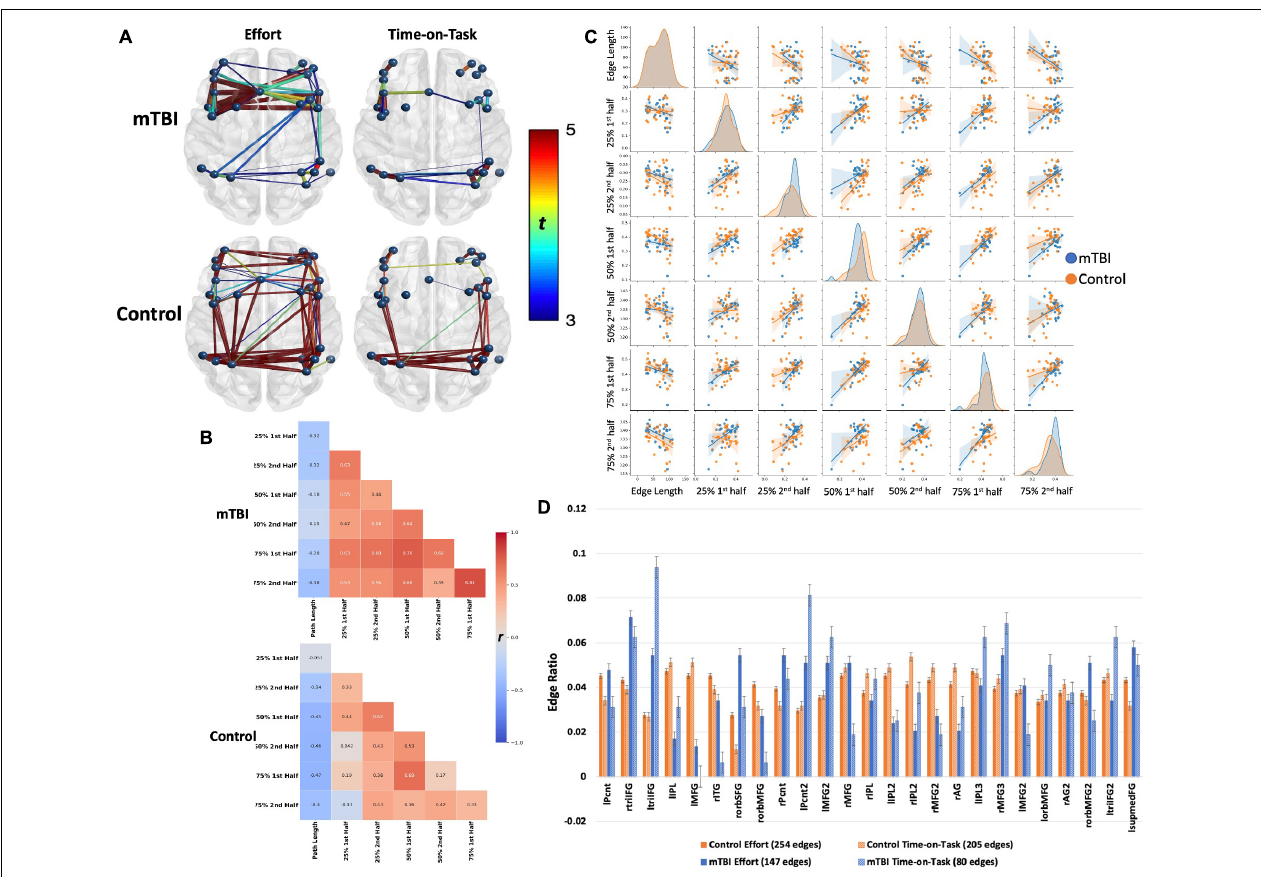
FIGURE 5 | Frontoparietal network connectivity by group. Both groups demonstrated robust main effects for effort level and TOT with similar spatial distributions across effects (effort or TOT) and across groups. The effects were stronger in the control group ( t -values presented by the color spectrum) than in the mTBI group but with small effect size ( d = 0.25). Spatial distribution was larger for the effort level than for TOT in both groups, but effect sizes did not differ (mTBI d = 0.31 for both, control d = 0.41 for effort, d = 0.4 for TOT). However, on visual inspection of the network, the distribution of significant edges and stronger edges ( t -values presented by color spectrum and edge thickness), was greater among the frontal nodes than the parietal nodes in the mTBI group. In contrast, connectivity was well distributed across nodes in the control group. This pattern, i.e., more and stronger connections in frontal than parietal nodes, is also evident in the TOT effect. The (B) heatmaps and (C) pairplot present the correlation strengths and distributions ( C , center diagonal) for edges that were significant at the effort level and TOT effects by group, and the scatter plots present the relationships between each of the effort levels by TOT. The heatmaps demonstrate that the mTBI group ( B , top) had stronger FC throughout the task with only slight increases in FC for the first half of each trial. In contrast, the connectivity of the controls varied consistently for the first half of the 50 and 75% effort levels. The pairplot presents the distributions of FP connectivity strength for the significant edges by group, and while the NBS results did not indicate strong group differences in the FP (evident in A ), these plots make evident the differing patterns of FC relationships by group. First, the distributions differ in the OC by TOT, with a more kurtotic peak for the first trial at 25% that flattens in the second half at 25%, and then remain near the same for the other effort levels with slight skew to the right (stronger connectivity). This was not the case in the mTBI group where the distribution was kurtotic for all effort levels. In both groups, there were bimodal distributions, with smaller numbers of participant data skewed to the left (weaker connectivity). Also evident in the (B) heatmaps is the negative correlation of edge length with FC. This negative correlation was slightly weaker in the mTBI group, and there was a trend toward more negative FC path length correlations with increasing effort level in the OC group. (D) Node degree, presented as the number of nodes by the total number of edges for each effect and group, demonstrated group differences in the numbers of connections each node was engaged in, with higher degree in frontal nodes for the mTBI group relative to the control group. The involvement of frontal nodes was particularly higher for the mTBI group in the TOT effect. lPcnt, left precentral gyrus; rtriIFG, right inferior frontal gyrus triangularis 1; ltriIFG, left inferior frontal gyrus triangularis 1; lIPL, left inferior parietal lobule 1; lMFG, left middle frontal gyrus 1; rITG, right inferior temporal gyrus 1; rorbSFG, right superior frontal gyrus orbitalis 1; rorbMFG, right middle frontal gyrus orbitalis 1; rPcnt, right precentral gyrus 1; lPcnt2, left precentral gyrus 2; lMFG2, left middle frontal gyrus 2; rMFG, right middle frontal gyrus 1; rIPL, right inferior parietal lobule 1; lIPL2, left inferior parietal lobule 2; rIPL2, right inferior parietal lobule 2; rMFG2, right middle frontal gyrus 2; rAG, right angular gyrus 1; lIPL3, left inferior parietal lobule 3; rMFG3, right middle frontal gyrus 3; lMFG2, left middle frontal gyrus 2; lorbMFG, left middle frontal gyrus orbitalis 1; rAG2, right angular gyrus 2; rorbMFG2, right middle frontal gyrus orbitalis 2; ltriIFG2, left inferior frontal gyrus triangularis 2; lsupmedFG, left superior medial frontal